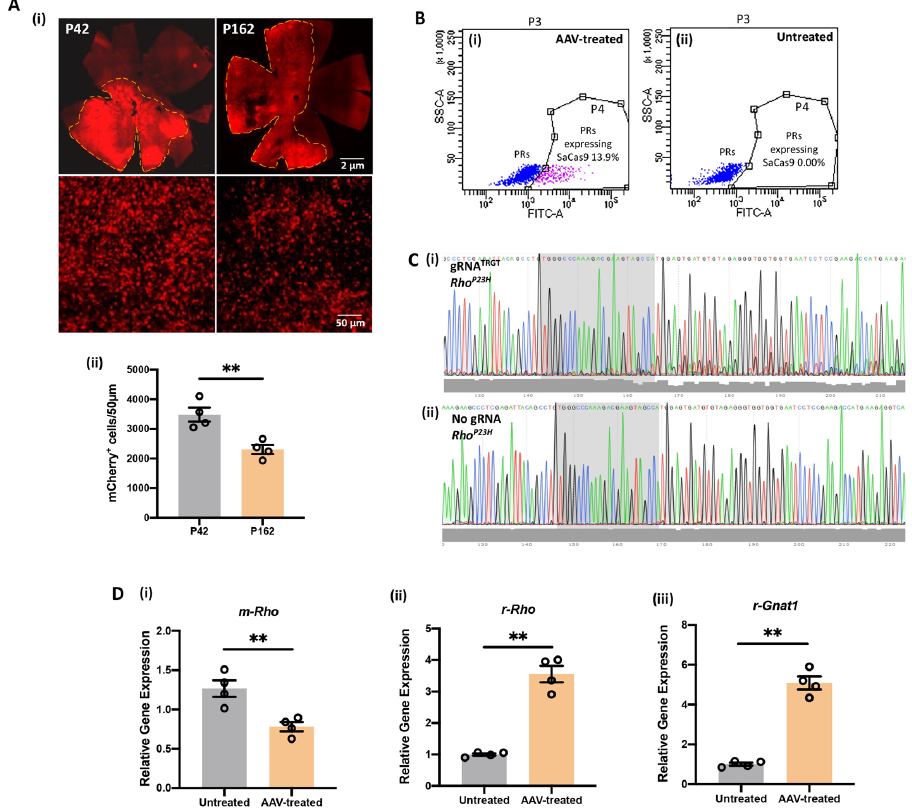
Figure 2. Assessment of CRISPR/Cas9-edited photoreceptors in vivo. ( A ) ( i ) . Representative retinal whole mount images (top panel) show broad distribution of mCherry expression at P42 and P162. The retina samples were taken from P23H rats that received a single unilateral trans-scleral subretinal injection of 2 μ L AAV-SaCas9/gRNA at P24. ( ii ) Bottom panel shows representative images of mCherry expression in photoreceptors. Scale bar, 2 mm for the top panel whole mount images, and 50 µ m for the bottom panel images. ( B ) High side-scatter of heterochromatin-identified photoreceptor perikarya (blue) in AAV-injected ( i ) and untreated eyes ( ii ) from each animal. PRs that expressed SaCas9 were sorted from AAV-injected eyes by SaCas9-HA fusion protein expression using HA.11- FITC ( i ): population shown in pink: 13.9%, which was absent in contralateral uninjected (control) eyes ( ii ): population shown in pink: 0.0%. ( C ) Following genomic DNA extraction and PCR amplification of the predicted cleavage site, Sanger sequencing confirmed Rho P23H disruption downstream of the gRNA binding site in treated eyes ( i ), shaded region, but not in uninjected (control) eyes ( ii ). The presence of overlapping base calls with decreased Phred quality scores (grey bars) indicates genomic variants generated by indels during DNA repair following NHEJ. ( D ) ( i – iii ) qPCR of mouse- Rho ( m-Rho ), rat- Rho ( r-Rho ) and rat- Gnat1 ( r-Gnat1 ) in AAV-treated and untreated retina. Data represent the mean ± SEM. ** p ≤